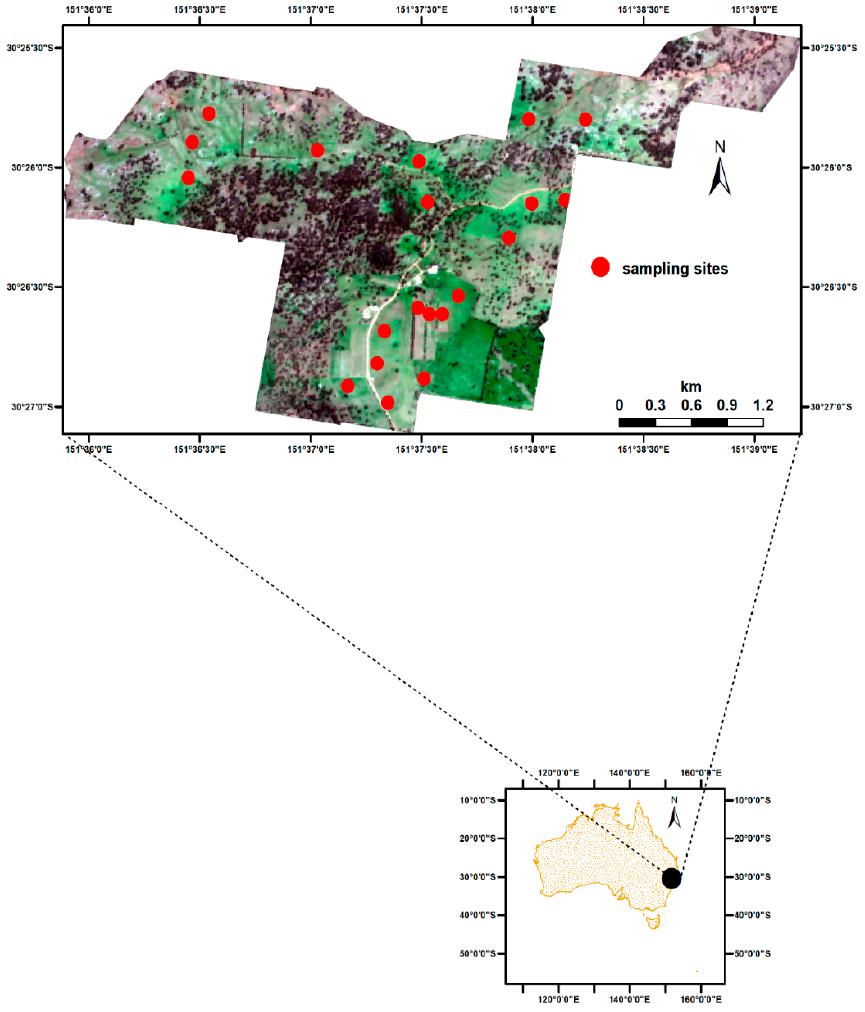
Figure 1. True color (RGB) Sentinel-2A image of study site (inset: location of study site in Australia) with the central location point of the 20 sampling sites (indicated by red circles and are not drawn to scale) from which 1080 instances were derived. Each sampling site was 900 m 2 .